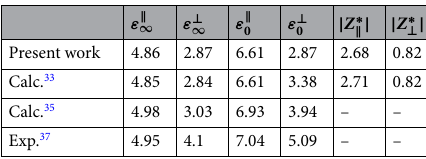
Table 2. Dielectric properties of